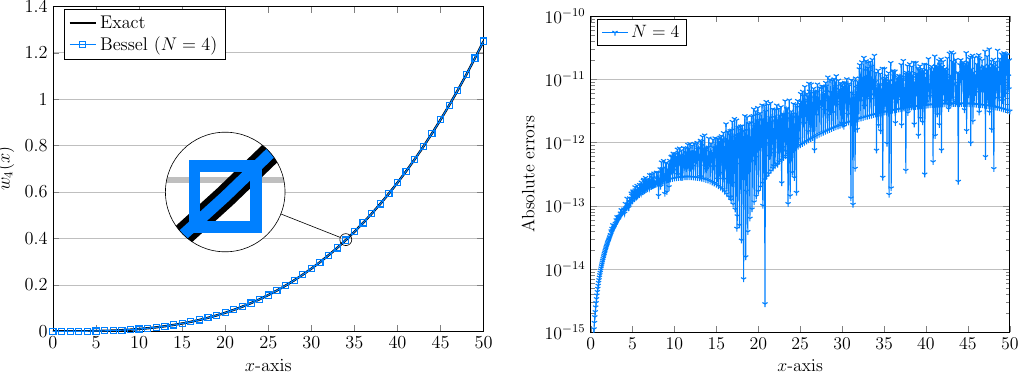
Figure 1. Graphs of the exact and computed solution using N = 4 ( left ) and the resulting absolute error ( right ) for (cid:96) = 50 in Example